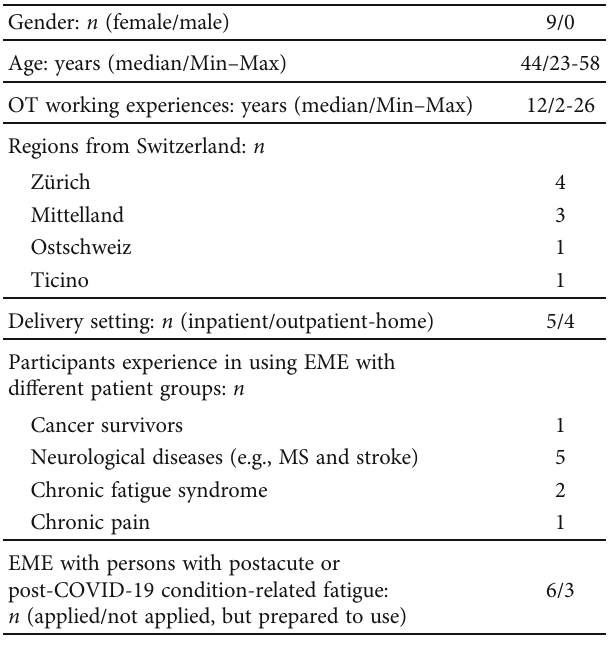
Table 2: Characteristics of the focus group